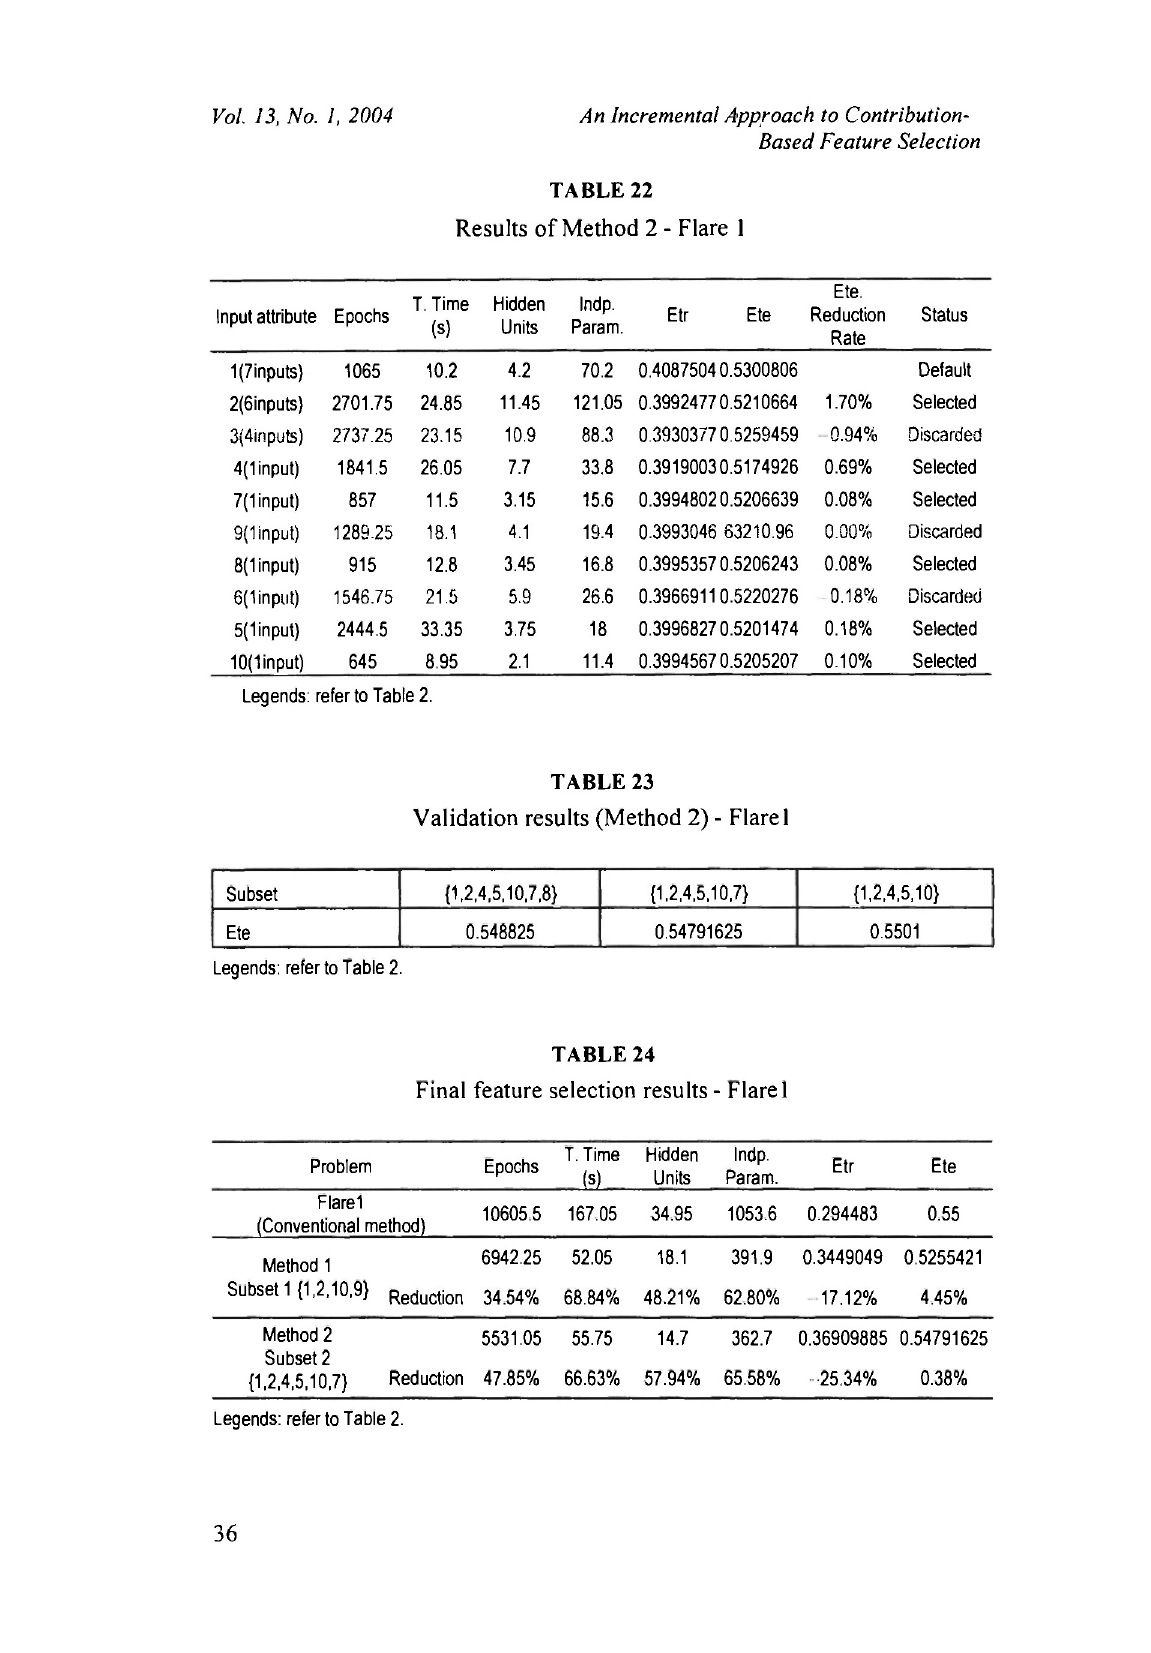
Final feature selection results - Flare